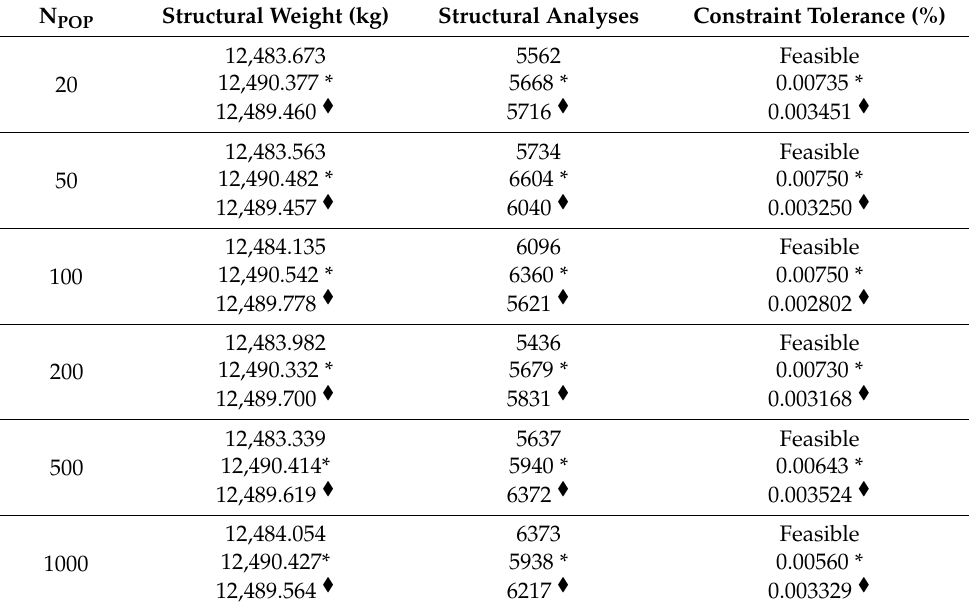
Table 1. Sensitivity of LSSO-HHSJA and other hybrid HS variants’ convergence behavior to popula- tion size for the 200-bar truss